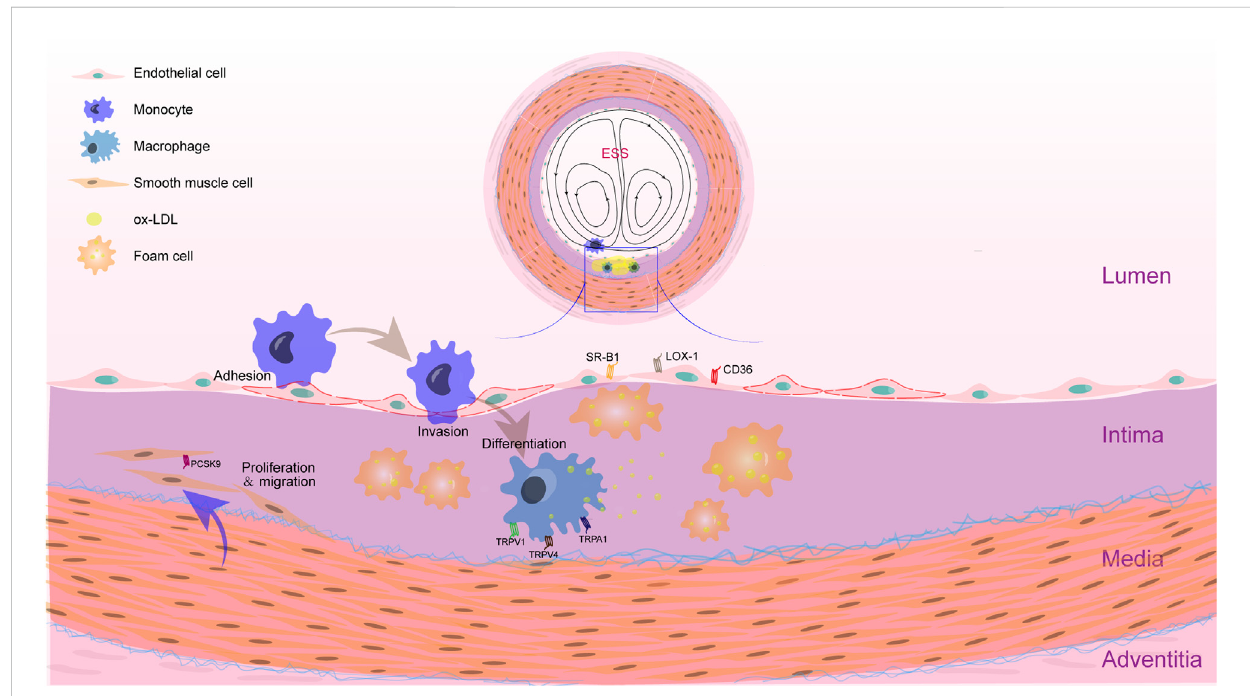
Feature of AS plaque in the location with disturbed shear stress. The accumulation of foam cells is an essential process in the formation of atherosclerotic plaque. Within the intima of blood vessels with disturbed shear stress, ox-LDL accumulated. Monocytes adhere to endothelial cells and invade into the intima. Then, monocytes differentiate into macrophages and phagocytose ox-LDL. When the phagocytosis of ox-LDL by macrophages increases and the ef fl ux is blocked, foam cells will be formed. VSMCs that are proliferated and migrated into the intima can also uptake the ox-LDL. Recent studies have shown that many receptors related to lipid metabolism in macrophages, VSMCs and ECs are mechanosensors, such as TRPV1, TRPV4andTRPA1inmacrophages,PCSK9inVSMCs,andSR-B1,LOX-1andCD36inECs.Theseelementsmayin fl uencethelipidmetabolisminresponse to altered mechanical